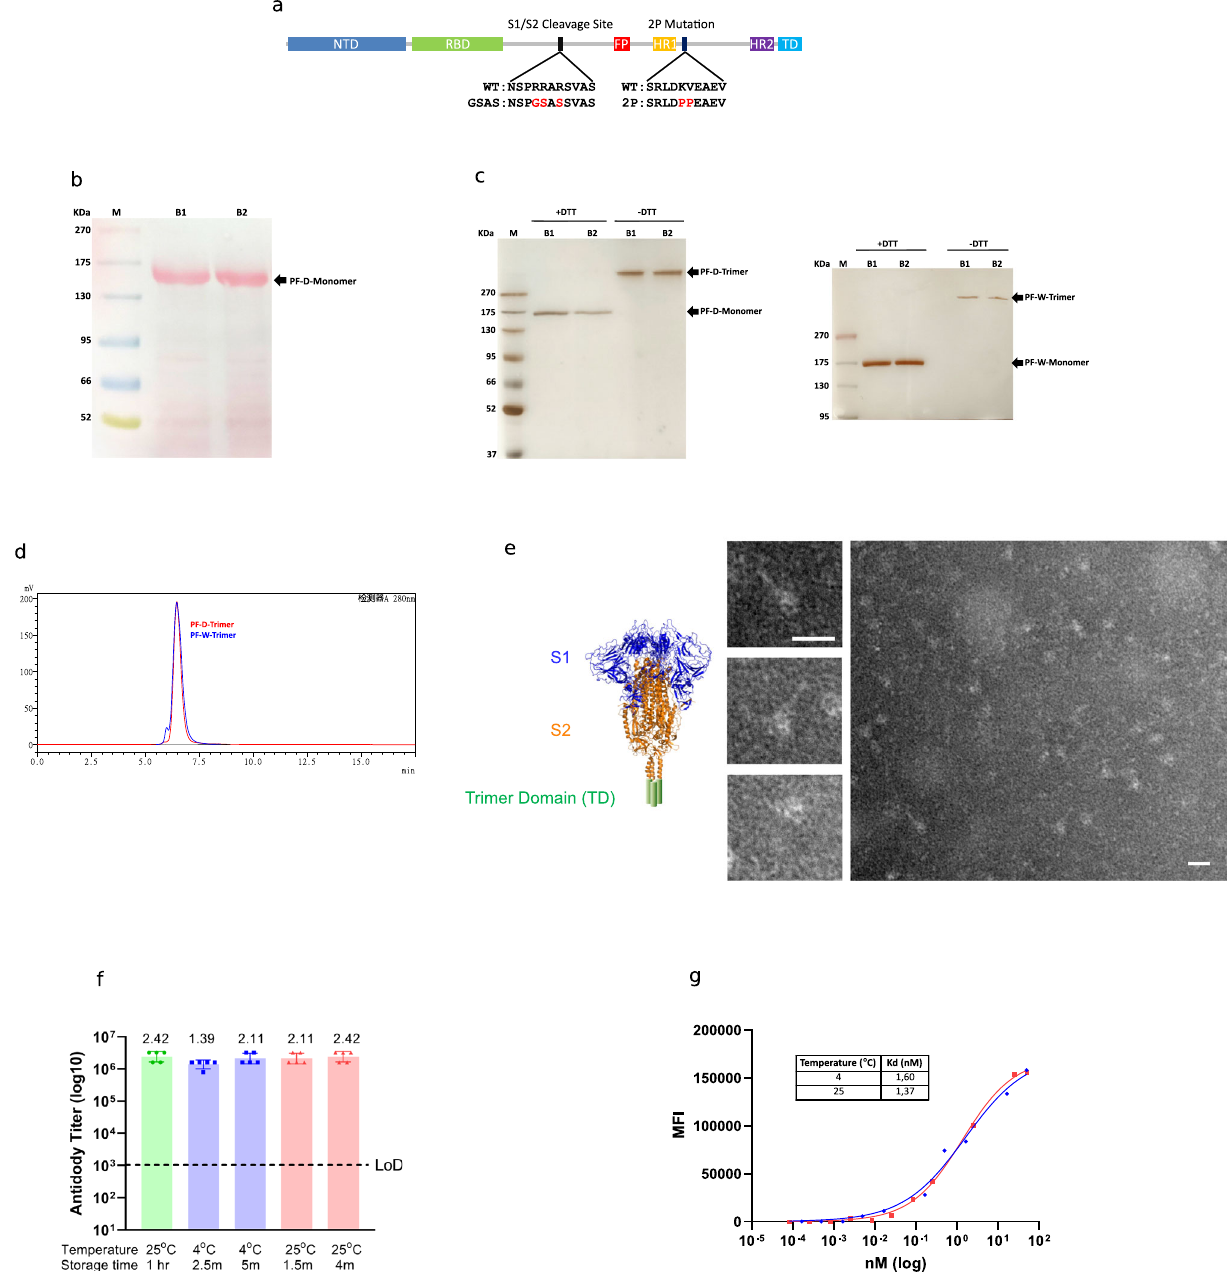
Fig. 1 Expression, puri fi cation, and characterization of the PF-trimers. a Schematic representation of the S ectodomain of SARS-CoV-2 Trimer Domain fusion proteins. b Analysis by reducing SDS-PAGE with Ponceau S staining of high-level expression of PF-D-Trimer from CHO cells in bioreactor cultures over a period of 11 days. Samples from two batches (B1, B2) were analyzed side by side. Each well contains 16 μ L of CHO cells culture supernatant. c The PF-Trimers are disul fi de bond-linked homotrimeric proteins as analyzed by SDS-PAGE with silver staining under reducing ( + DTT) and non-reducing (-DTT) conditions. Samples from two puri fi cation batches (B1, B2) were analyzed side by side. Each well contains 1 µg of PF-Trimers as quanti fi ed by molar absortivity at 280 nm. Each well of a gel derives from the same experiment and has been treated in parallel. d SEC-HPLC analysis of the immunoaf fi nity puri fi ed PF-D-Trimer (red) and PF-W-Trimer (blue) showing a MW of approximately 525 kDa and a purity of more than 99%. e PF-D-Trimer schematic diagram and representative negative-stain EM images with homotrimeric S protein in the prefusion conformation. The images on the left are partial enlargements of the image on the right as indicated with the black arrows. The sample contains assembled spike trimers. Scale bar 20 nm. f PF-D-Trimer stability assays. Antibody titers for sera obtained from Sprague-Dawley rats 28 days following immunization with 10 µg PF-D-Trimer formulated with alum plus CpG 1018 that had been stored at 4 °C or 25 °C for up to fi ve months, compared to freshly formulated PF-D-Trimer (left, green circles). Points represent individual animal; bars indicate geometric mean titers (GMT) responses (with geometric standard deviation). Dotted lines indicate the limit of detection, LOD; 1 × 10 5 . g Dissociated PF-D-Trimer cellular binding using HEK293/hACE2 cells. The binding assays were performed as described in “ Methods ” . MFI, Median Fluorescence Intensity. ● Formulation stored at 4 °C for six months, ■ Formulation stored at 25 °C for six